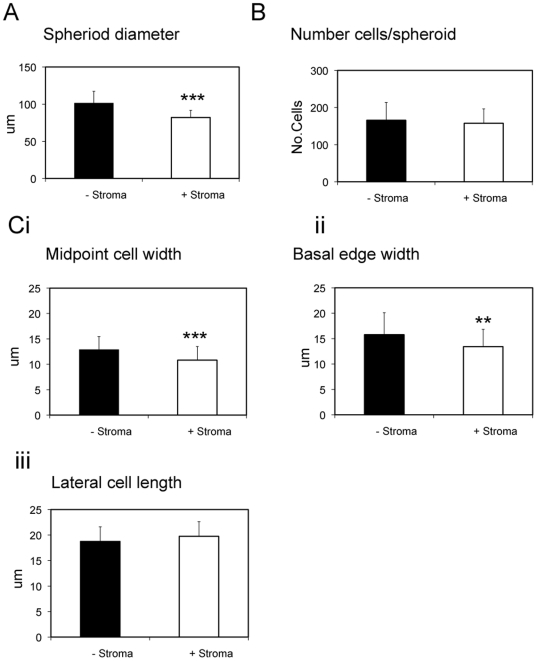
Stroma decreases spheroid size by decreasing cell width.(A) The diameter of 3D BPH-1 acini was measured in the presence or absence of stroma after 7 days in culture. Fifty acini cultured with stroma and 50 cultured without stroma were measured at mid-sections. The data represents five separate experiments, which were performed with different stromal cultures and Matrigel batches. (B) The number of cells within BPH-1 acini cultured with and without stroma were counted, according to Pearson et al. [22]. The cells from 10 spheroids were counted per condition and the experiment was repeated twice. (C) The width of individual cells within acini were measured at the mid-point of the cell (Ci) and at the basal edge of the cell (Cii). The length of individual cells was measured at their longest point (Ciii). Fifty cells were measured from a minimum of 10 spheroids per condition. The data represents three experiments, ***p<0.0005, **p<0.005, *p<0.05 (paired t-test).